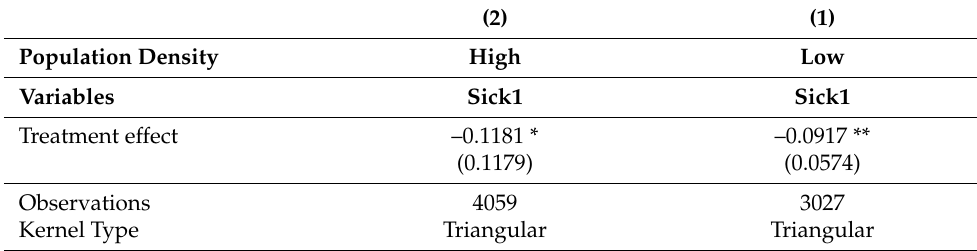
Table A1. Upstream–downstream health gap with different populations.